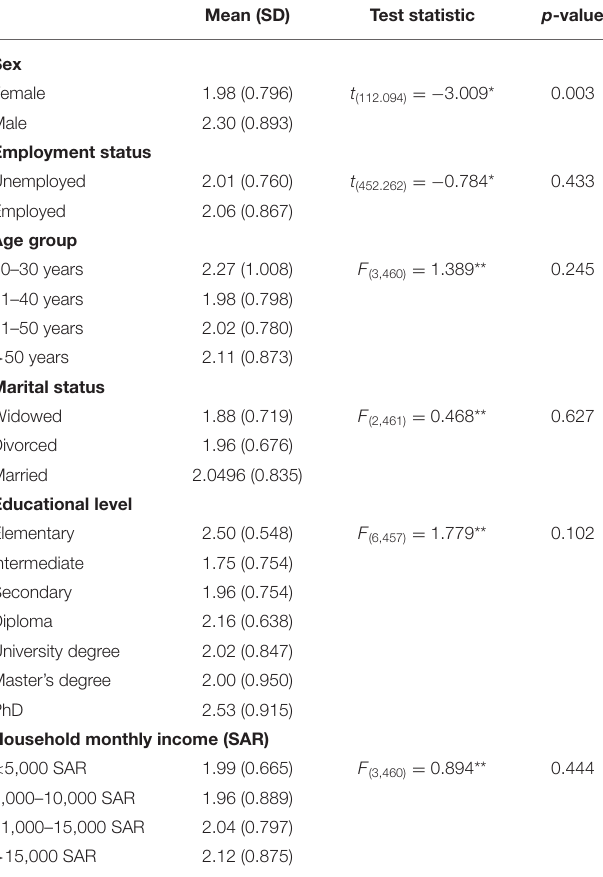
TABLE 5 | Comparison of mean values of the attitude of respondents of parents TABLE 4 | Comparison of mean values of the knowledge of respondents of toward CBT in relation to their personal characteristics ( N = 464). parents about CBT in relation to their personal characteristics ( N = 464). Mean (SD) Test statistic p -value Mean (SD) Test